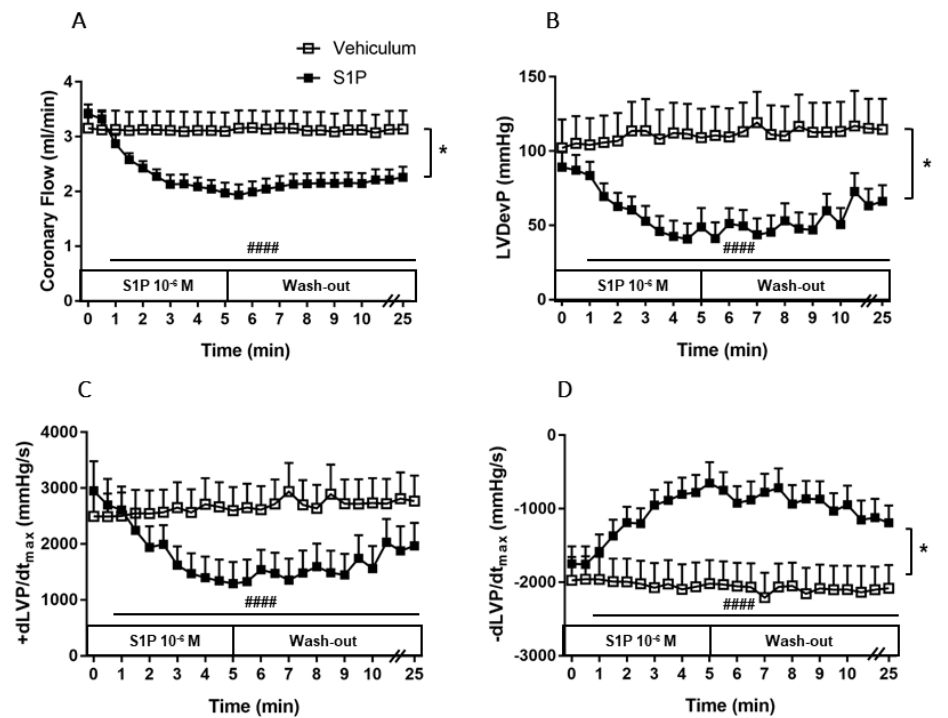
Figure 2. Effects of S1P on coronary flow (CF) ( A ), left ventricular developed pressure (LVDevP) ( B ), +dLVP/dt max ( C ) and − dLVP/dt max ( D ) of isolated mouse hearts. S1P (10 − 6 M) or its vehicle was administered to the perfusate of isolated wild-type (WT) murine hearts for 5 min. The infusion was followed by a 20-min wash-out period. Administration of S1P resulted in a remarkable decrease in CF, which prevailed throughout the infusion and the wash-out period ( p < 0.0001). CF reduction compromised left ventricular contractile performance as evidenced by a concomitant decrease in LVDevP, +dLVP/dt max and − dLVP/dt max ( p < 0.0001). Mean ± SEM; n = 6, 9; #### p < 0.0001 vs. baseline (pre-infusion value), * p < 0.05 vs. vehicle; two-way repeated measurement ANOVA and Dunnett’s post hoc test.